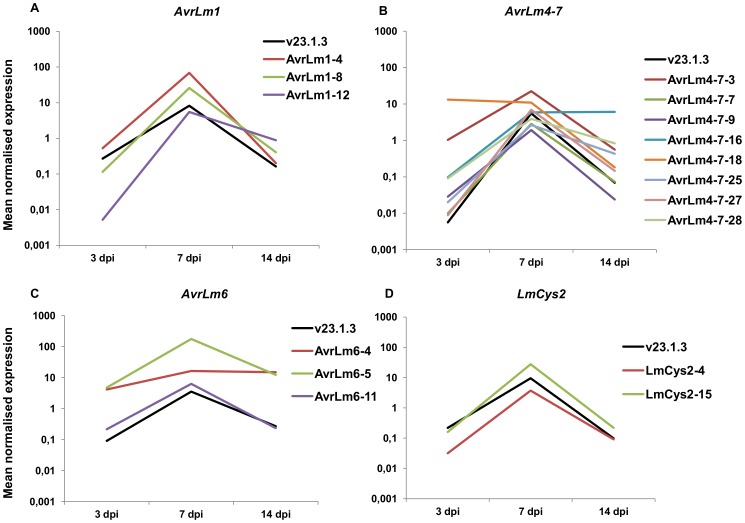
Expression of four effector genes in planta following ectopic integration in GC-isochores of the genome.Expression of the effector genes AvrLm1
 (A), 
AvrLm4-7
 (B), 
AvrLm6
 (C) and 
LmCys2
 (D) was analysed by qRT-PCR in the wild type isolate v23.1.3, in which these genes are located in AT-isochores and compared to their expression in different transformants (v29.3.1-AvrLm1-x, NzT4-AvrLm4-7-x, v29.3.1-AvrLm6-x, or v29.3.1-LmCys2-x), in which they are inserted in GC-isochores. Gene expression levels are relative to β-Lmtubulin. 3 to 14 dpi: RT-PCR products obtained from RNA isolated from oilseed rape cotyledons (susceptible cultivar Westar) 3 to 14 days post infection. RNA extracted from uninfected cotyledons and water were used as negative controls. Each data point is the average of two technical repeats (two RT-PCRs).